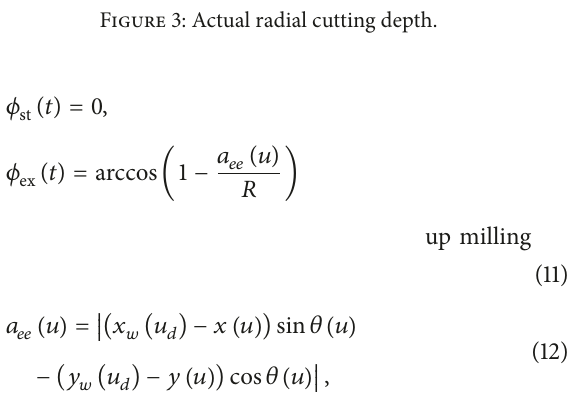
Figure 3: Actual radial cutting